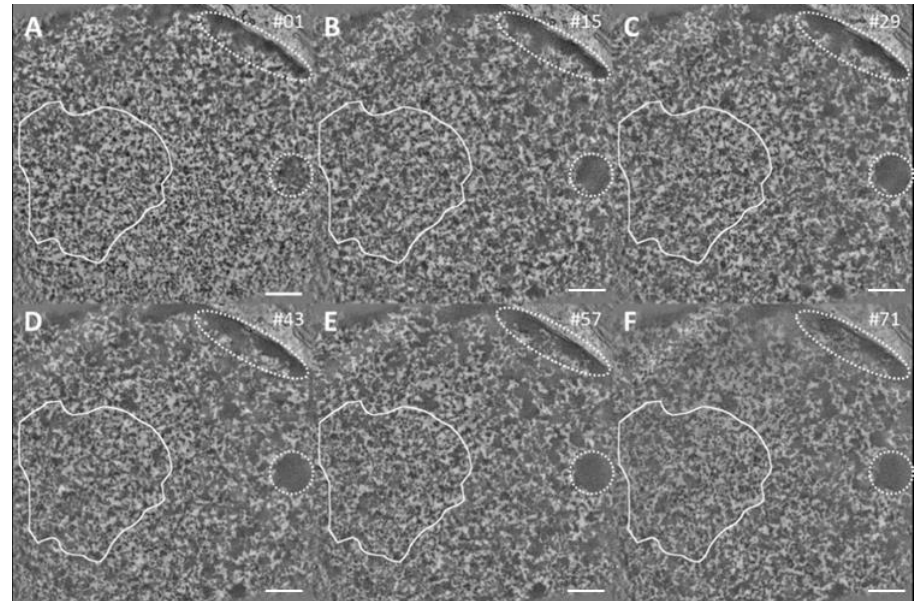
Figure 5. Tomography of an irradiated area stained by ChromEMT. A gallery of 2 nm thick tomographic slices extracted from a dual axis tomographic reconstruction of 250 thick section of an irradiated U2OS cell. The chromatin structure shows no obvious difference between the inside and outside of the damage site (white outline) through the whole volume. Roundish domains (inside doted areas) indicating HC. For further comparison see Supplemental Figure S5 which shows the tomography of a non-irradiated area. Slice numbers shown in the upper right corner. All scale bars: 500 nm. Slices thickness 2 nm.